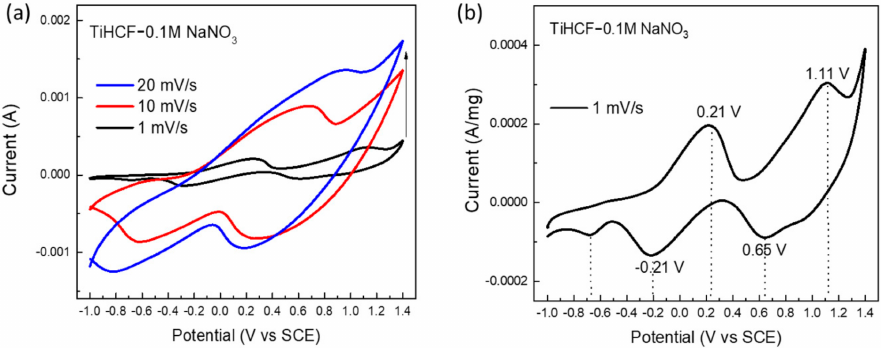
Figure 1. Three-electrode system: ( a ) CV curves of TiHCF in 0.1 M NaNO 3 electrolyte at different scan rate; ( b ) CV curves of TiHCF at 1 mVs − 1 , using mass normalized